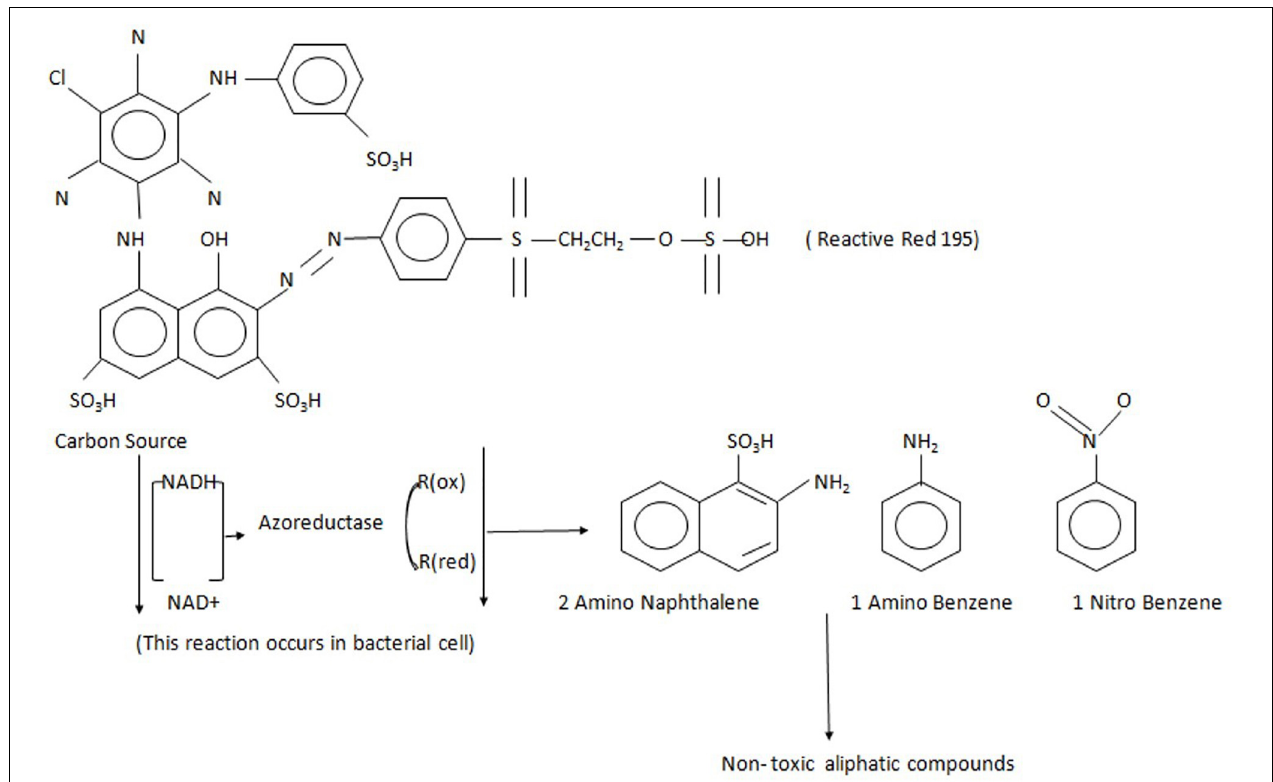
FIGURE 3 | The mechanism action of azo reductase on Reactive Red 195 dye, which forms the aromatic amines and further gets degraded to non-toxic aliphatic compounds.